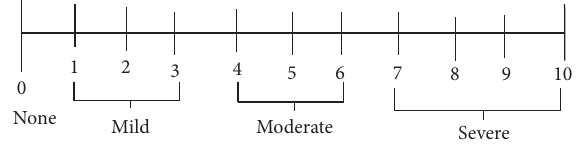
Figure 1: Numeric rating scale